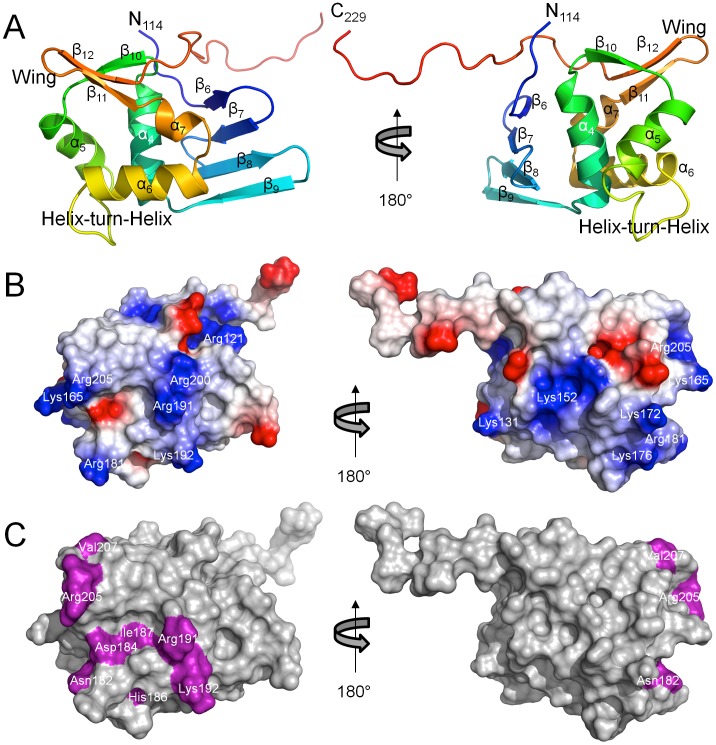
Solution structure of ChxREff.
A, Cartoon ribbon diagram of the minimized mean structure of C. trachomatis ChxREff (residues 114–229) colored blue (N-terminus) to red (C-terminus). The topology of ChxREff is β6–β7–β8–β9–α4–β10–α5–α6–α7–β11–β12. B, Surface representation of electrostatic potential, generated by DelPhi [40], of ChxREff. Color scheme represents regions of negative (red) and positive (blue) charge density contoured at ±3 e/kT. Structure is oriented the same as panel A. C, Surface representation of ChxREff with surface exposed side chains targeted for site directed mutagenesis colored magenta. Structure is oriented the same as panel A. All three panels are rotated 180° on the right.